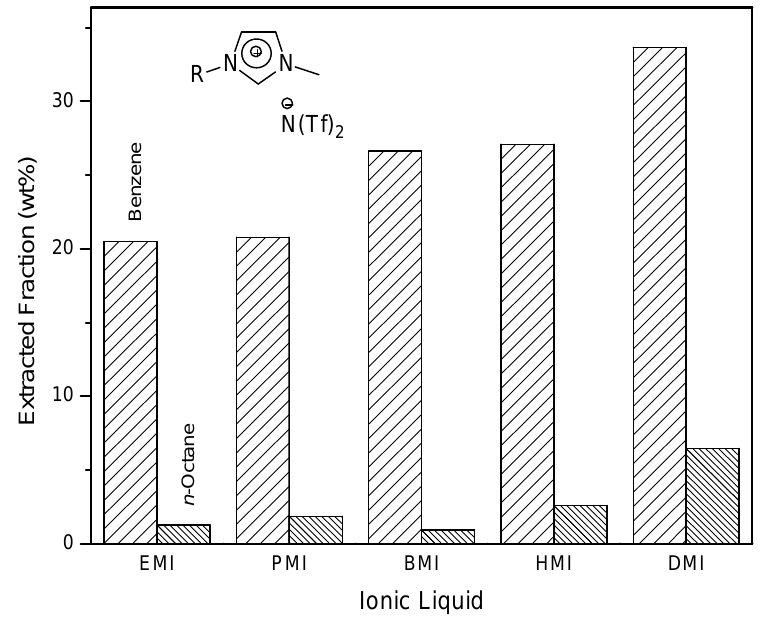
Figure 4. Benzene and n -octane extracted fractions from a model fuel (10 wt % of benzene in n- octane) by dialkyl imidazolium ILs (IL:benzene ratio of 1:1, mol/mol; 1 ml of IL) with different length side